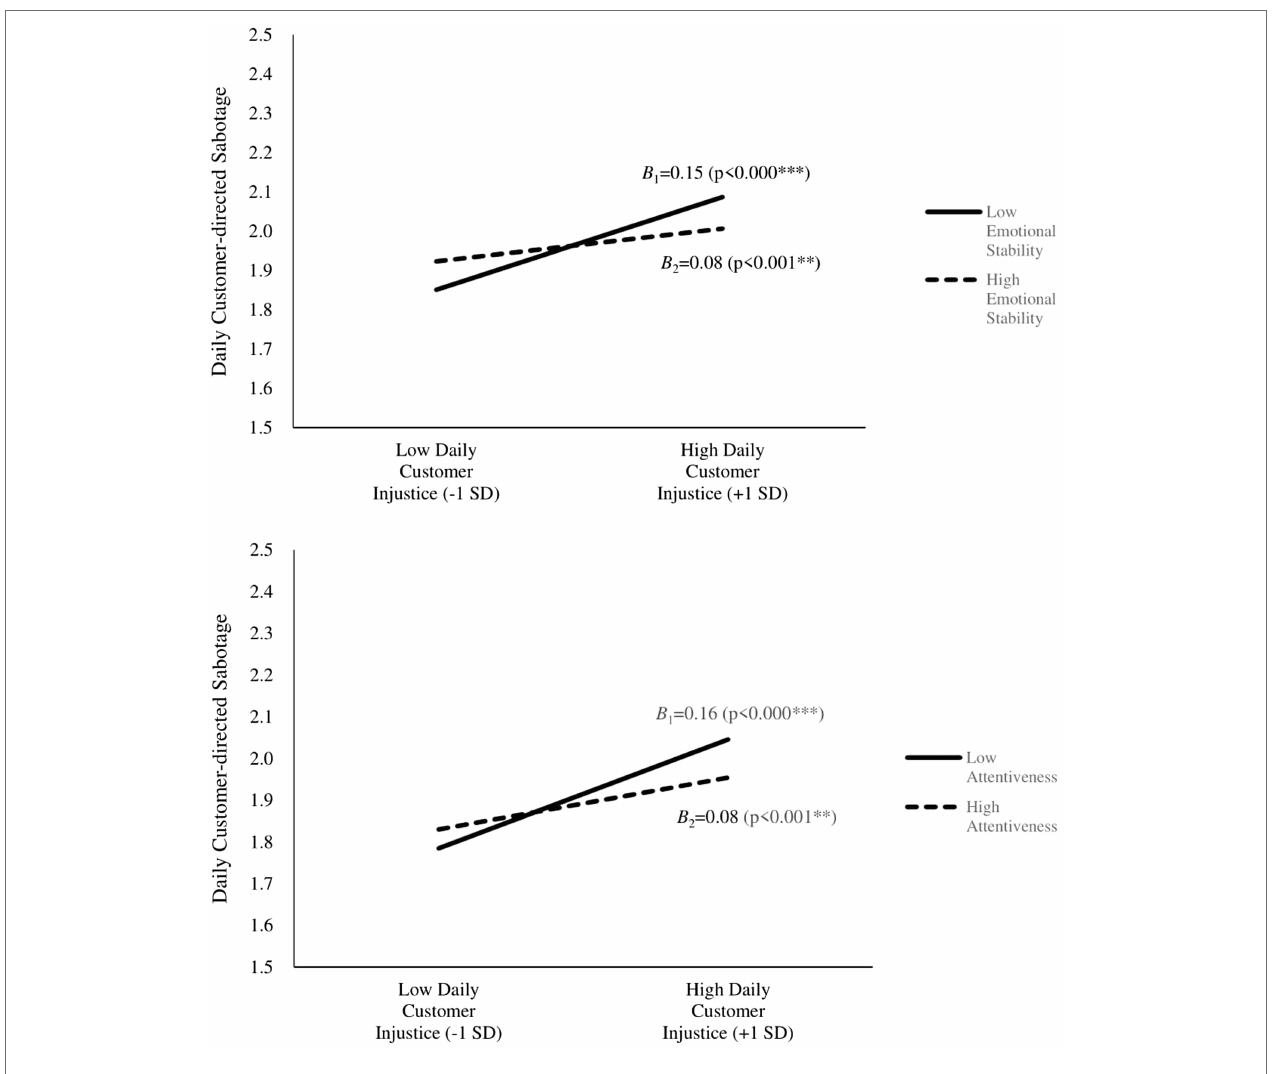
FIGURE 1 | Two-way interactions.